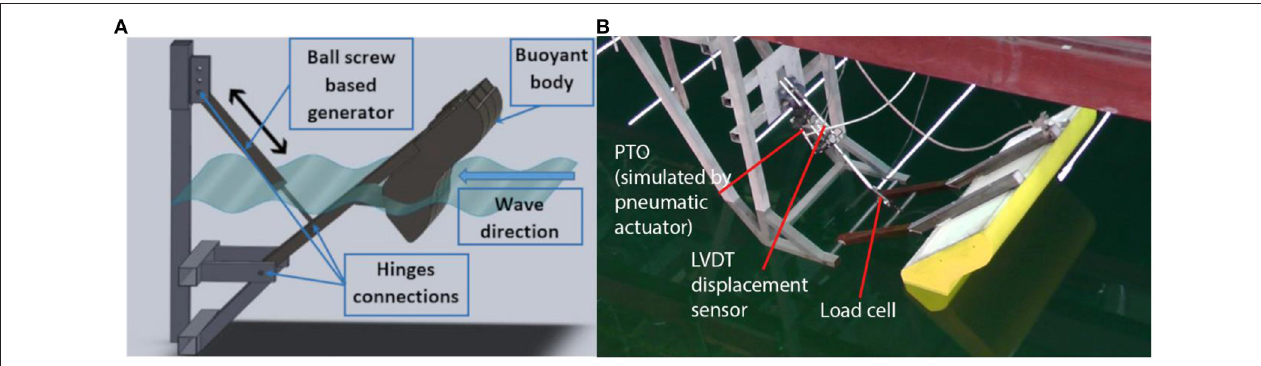
FIGURE 9 | PIVOT WEC system operating principle (A) . PIVOT WEC system small scale test model set-up (B)